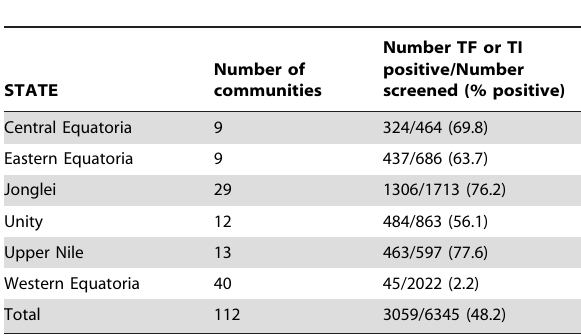
Table 1. Descriptive statistics of active trachoma in children aged 1–9 years in geo-referenced communities.